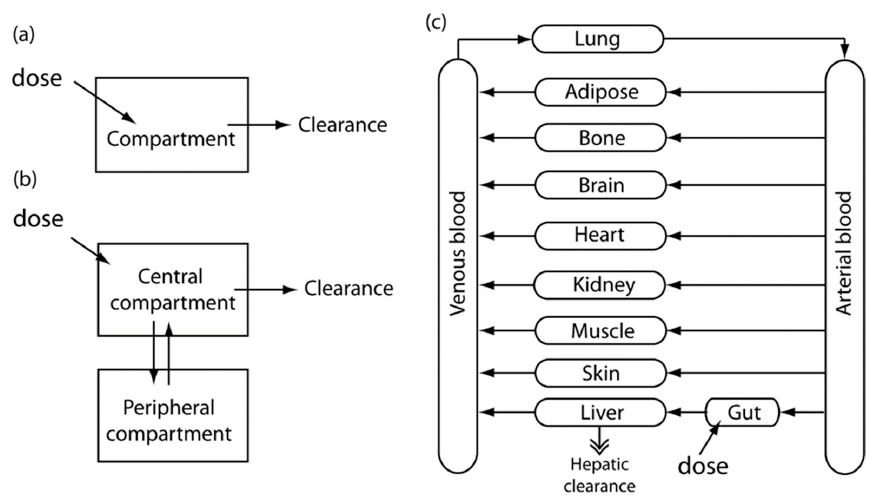
Figure 1. Schematic diagrams for the basic concept of PK models. Image reprinted from [4] with the permission of John Wiley & Sons. ( a ) One-compartment model; ( b ) Two-compartment model; ( c ) A more complex PBPK model.